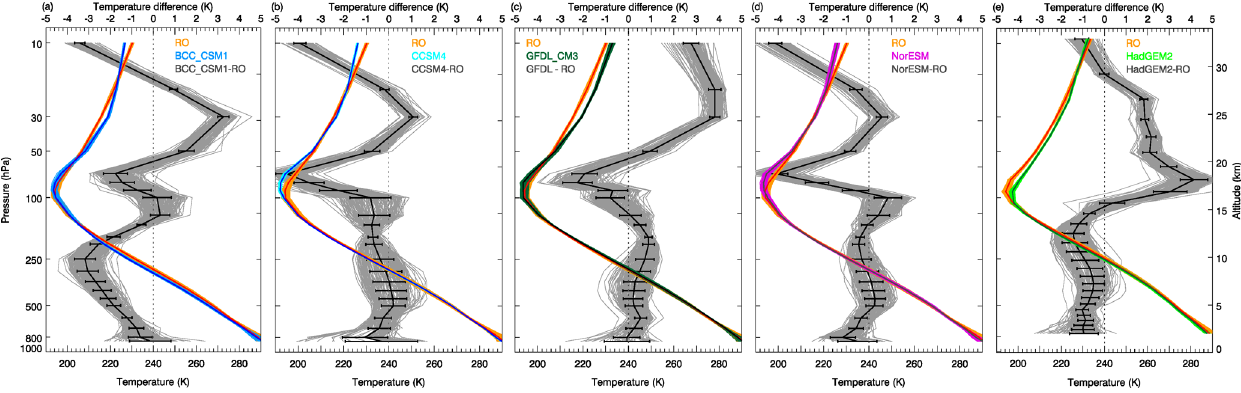
Figure 5. Temperature difference of model data minus RO observations (upper axes) and collocated temperature profiles (lower axes) for all classes ( ω 500 and T 2m ) in the tropics, shown for BCC-CSM1.1 (a) , CCSM4 (b) , GFDL-CM3 (c) , and NorESM1-M (d) at pressure levels and for HadGEM2-A (e) at corresponding altitude levels. Mean and standard deviation of the differences are indicated in